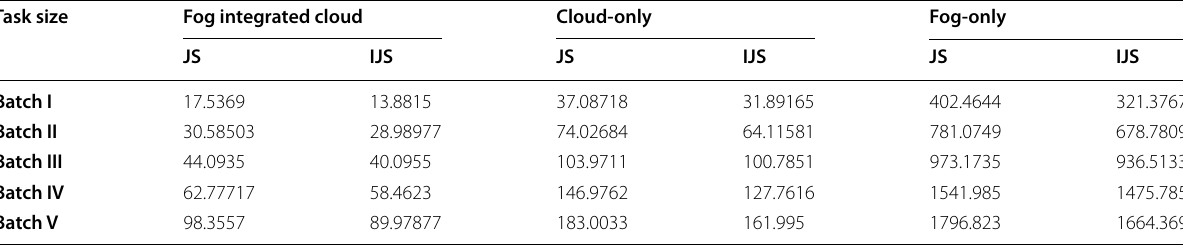
Table 6 ECT v/s Batch Size for Fog Integrated Cloud, Cloud-Only and Fog-Only Architectures Task